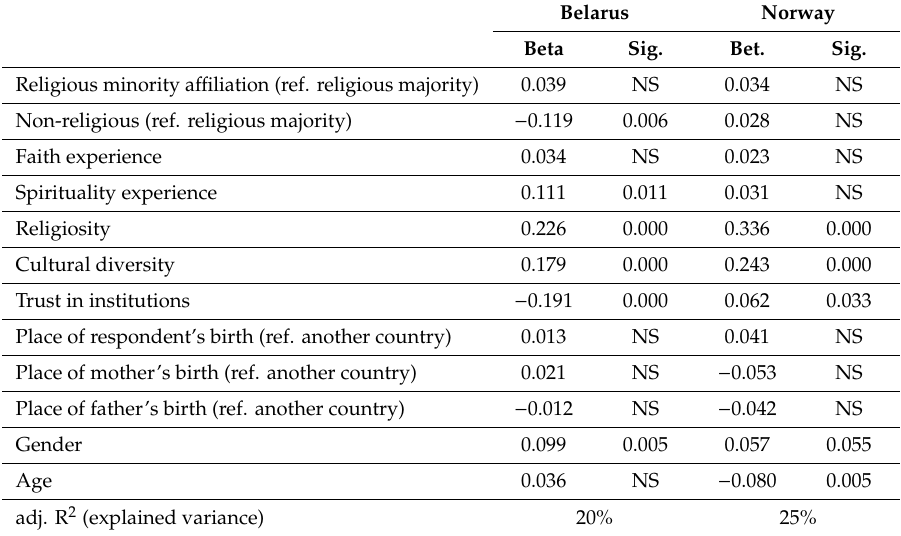
Table 6. Regression analysis for religious freedom.